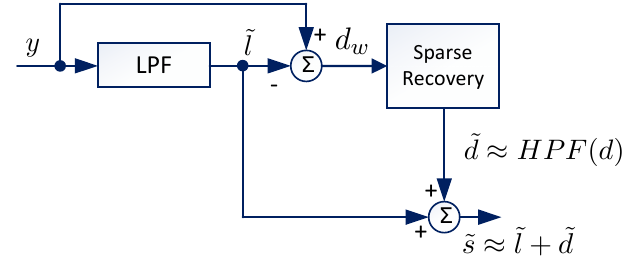
Figure 1. Block diagram of the sparsity electrocardiogram (ECG) denoising